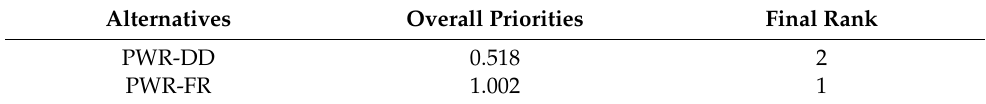
Table 5. Evaluation results of direct disposal and Pyro-SFR fuel cycle using AHP.